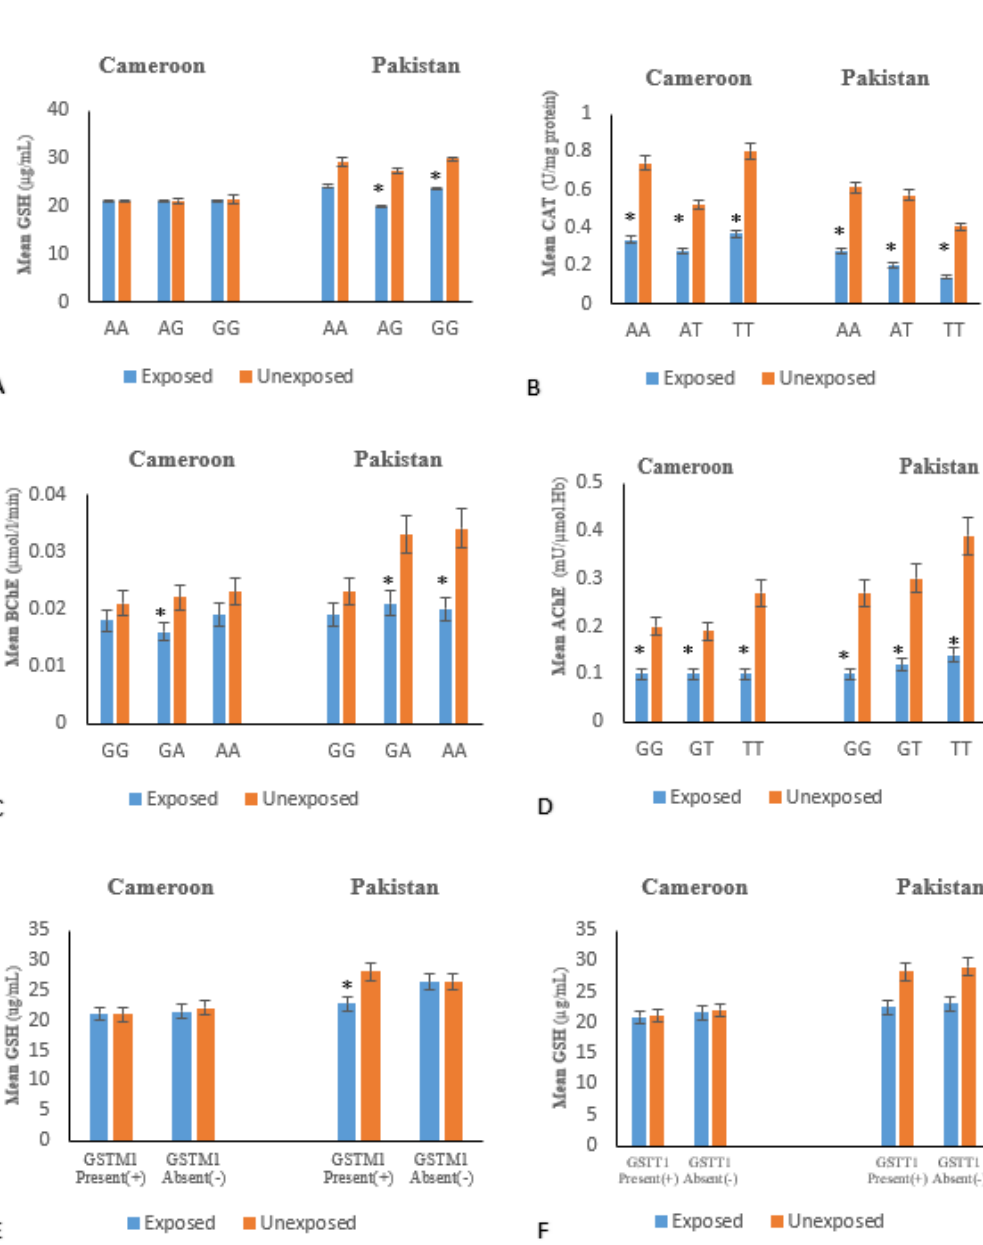
Figure 2. Variation of biochemical parameters according to different genotype: The results were significant if * p ≤ 0.05. ( A ) GSTP1 gene; ( B ) CAT gene; ( C ) BChE gene; ( D ) ACHE gene; ( E ) GSTM1 gene; and ( F ) GSTT1 gene.